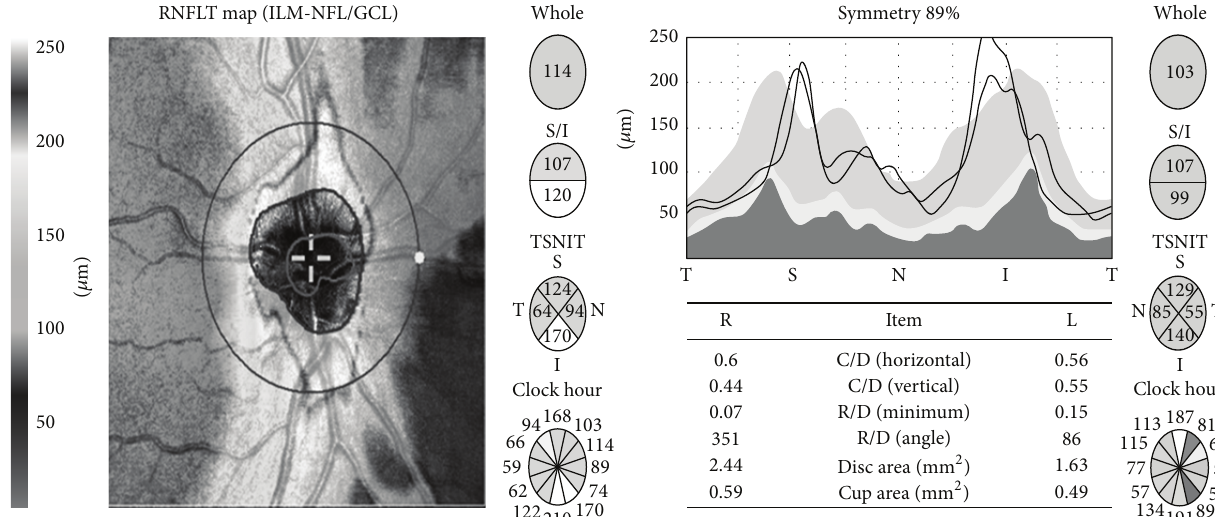
Figure 2: Optic disc parameters and retinal nerve fiber layer